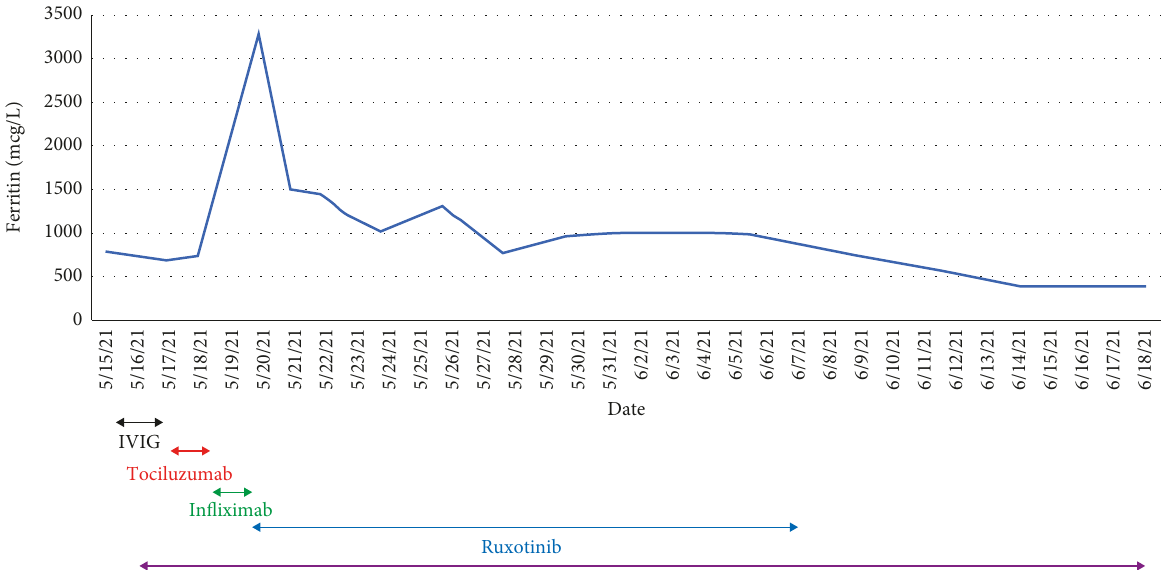
Figure 1: Ferritin trend against biologics